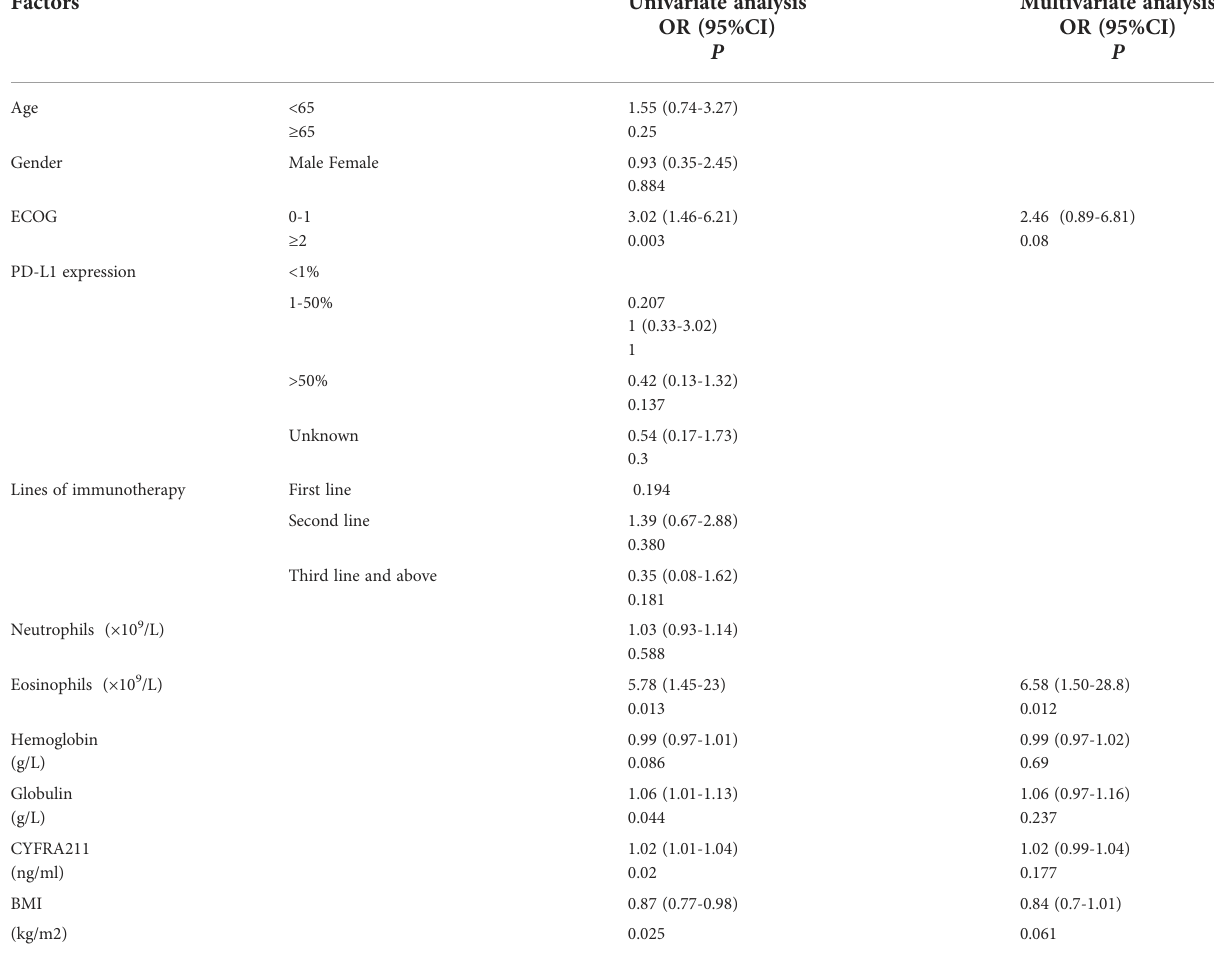
TABLE 3 Univariate and multivariate analyses of factors associated with grades 3-5 irAEs.